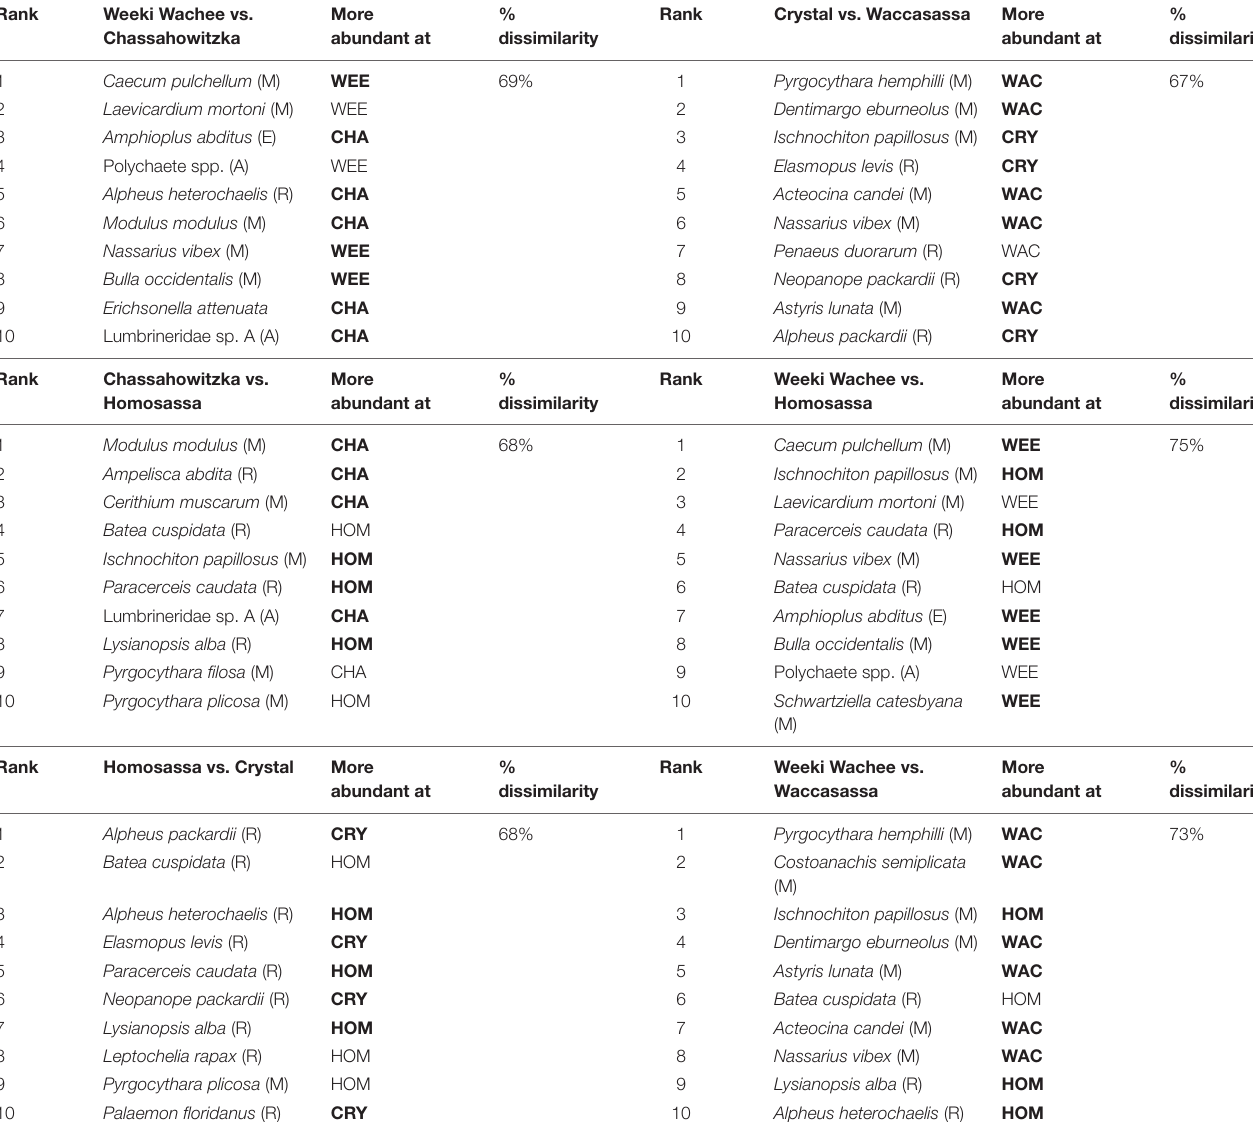
TABLE 3 | Top 10 species contributing to significant differences between community composition among estuarine systems in SIMPER